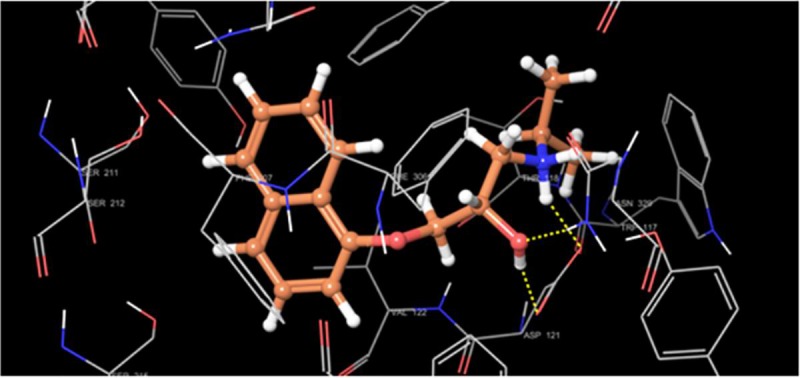
Binding pattern of propranolol with β1.